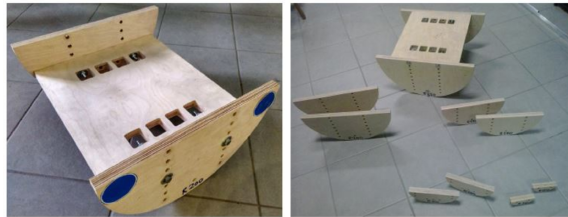
Figure 1. Balance board, with interchangeable wheels and adjustable board heights.